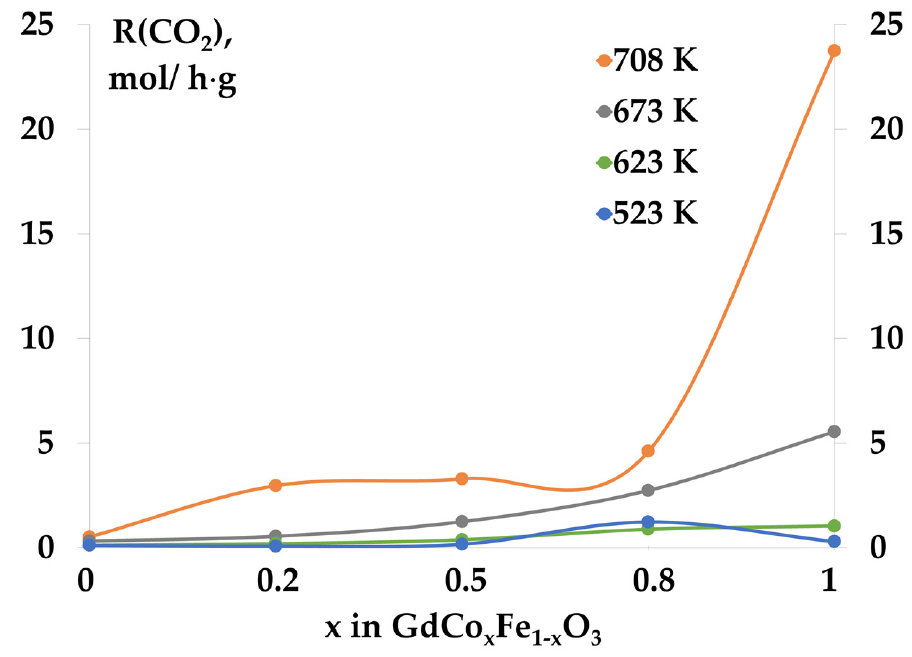
Figure 6. Temperature dependences of the CO 2 formation rates over GdCo x Fe 1 − x O 3 complex oxides (CO:H 2 ratio = 1:2; GHSV = 8700 h − 1 ).